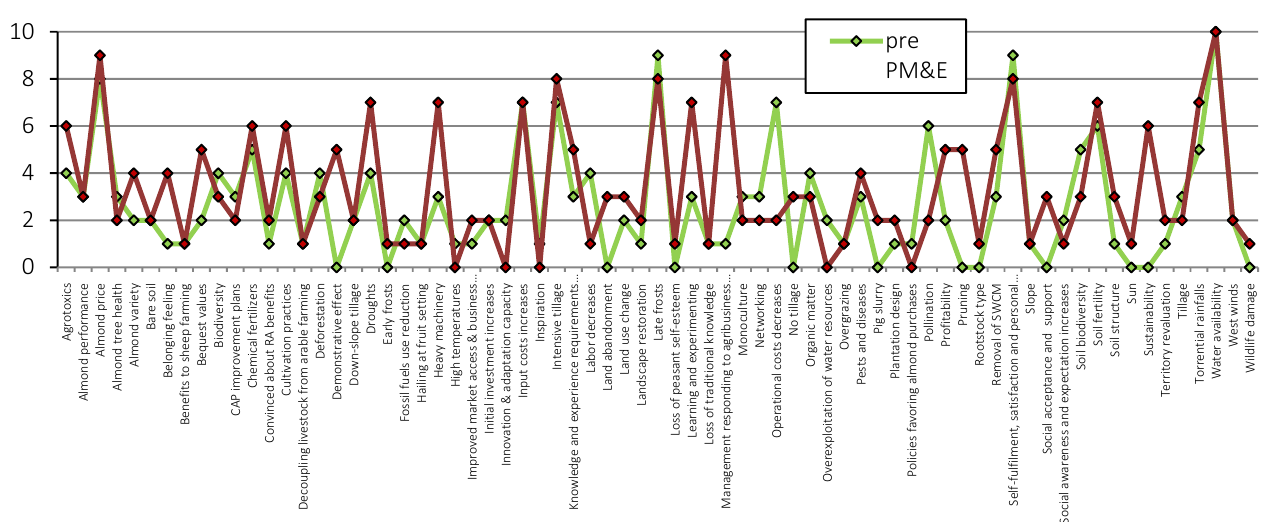
Figure 1 Frequency of citation of mentioned factor pre and post